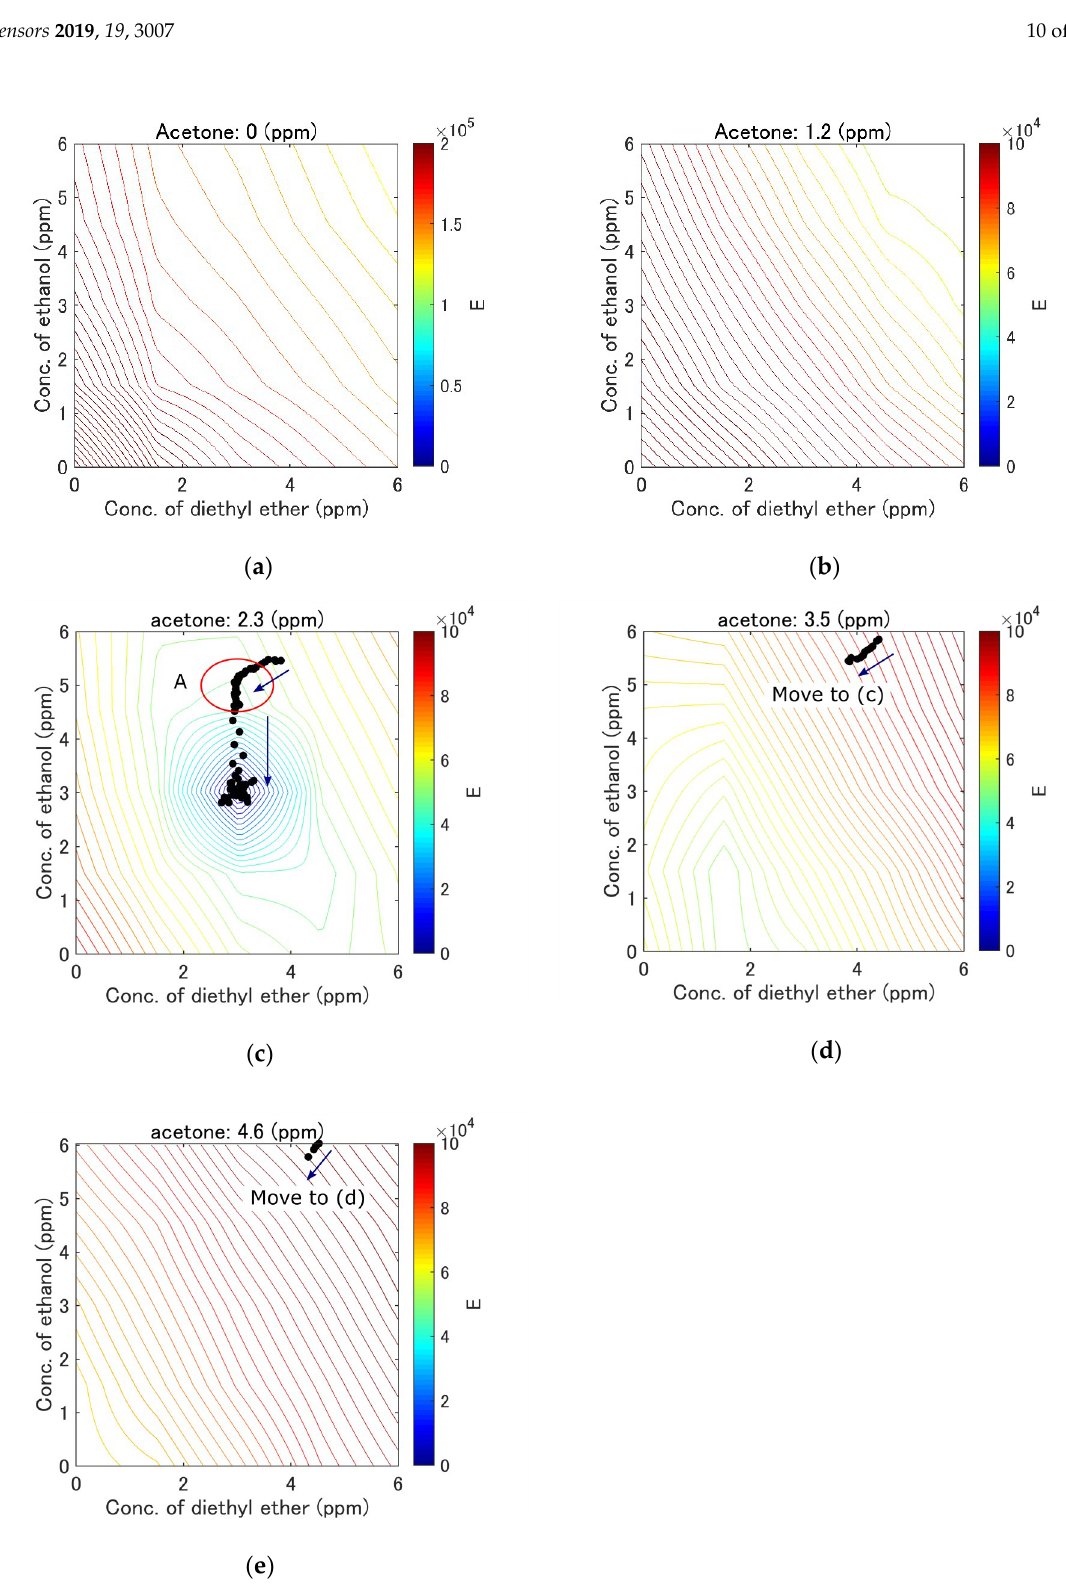
Figure 6. Part of the measurement results of pure gases and a ternary gas mixture. ( a ) Pure diethyl ether (6.1 ppm). ( b ) Pure ethanol (6.1 ppm). ( c ) Pure acetone (4.6 ppm). ( d ) The ternary mixture of